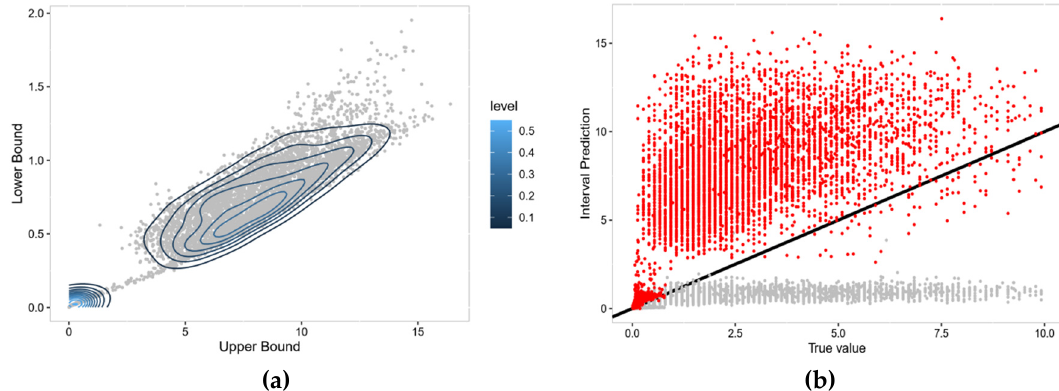
Figure 9. ( a ) The density scatter plot of upper bound (x-axis) against lower-bound (y-axis). ( b ) Scatter plot of the relation between point estimation (x-axis) and predicted intervals (y-axis); red points are for upper bounds and grey points are for lower bounds. The black line is the fitted line. (unit: μ g/m 3 ).